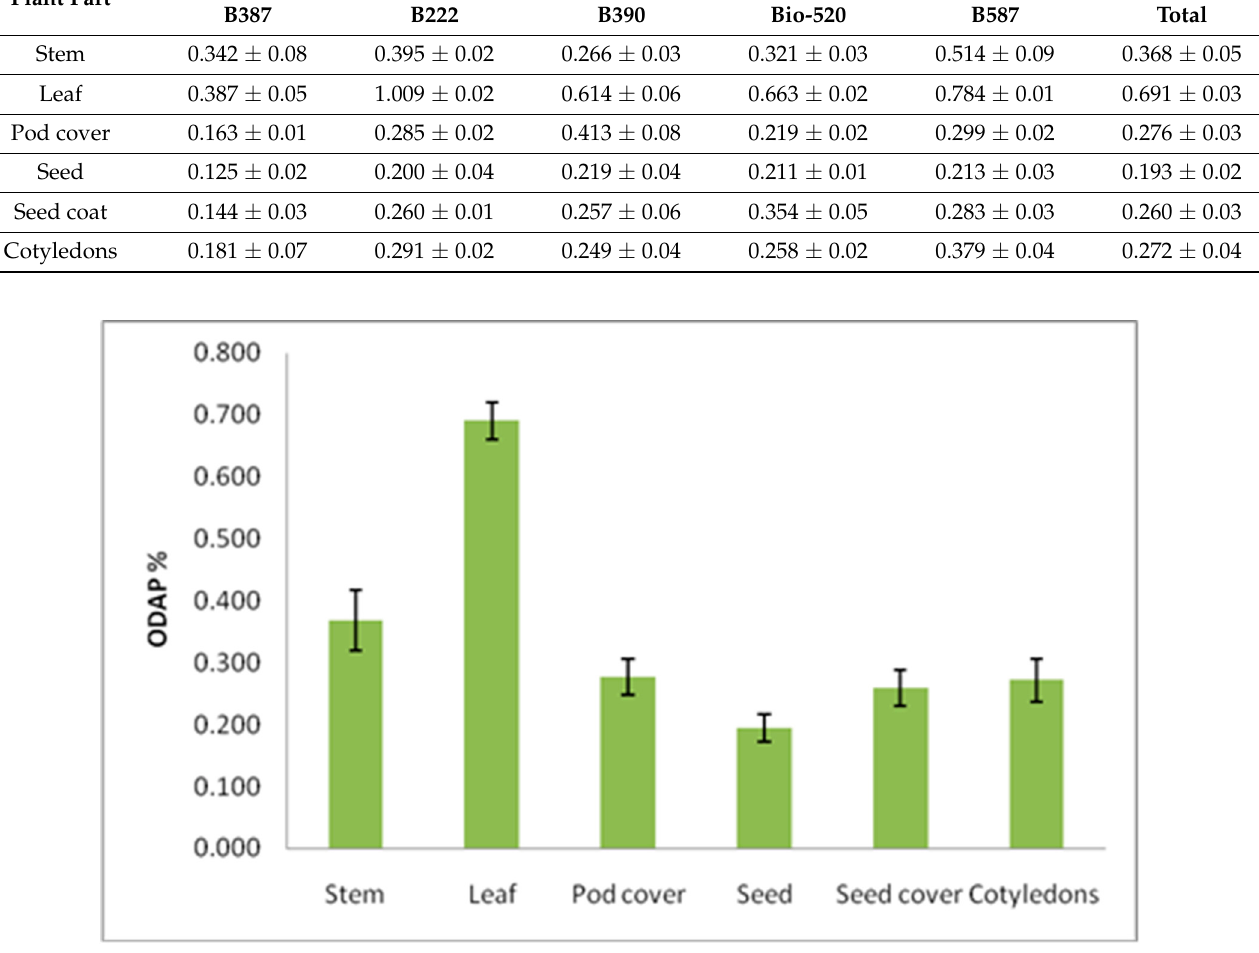
Figure 3. ODAP content variation in diffrent plant parts at mature stage in grass pea. Y axis presents ODAP content in percent, and X axis denotes different plant parts as source of sampling for ODAP estimation.